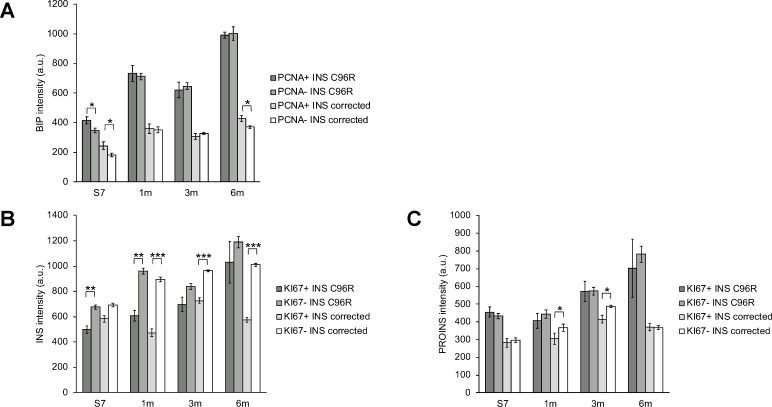
Correlation of proliferation markers with ER-stress marker levels in INS+ cells.(A–C) Quantification of BIP, INS and PROINS staining mean fluorescence intensity per individual proliferating (PCNA+ or KI67+) and non-proliferating INS+ cell across genotypes and timepoints. *p < 0.05, **p < 0.01, ***p < 0.001, Student’s t test. Data represent mean ± SEM, n = 7–268, a.u. = fluorescence intensity arbitrary units.